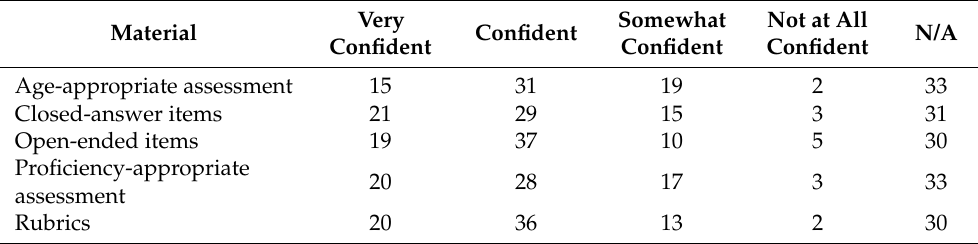
Table 5. Confidence in assessment materials development by